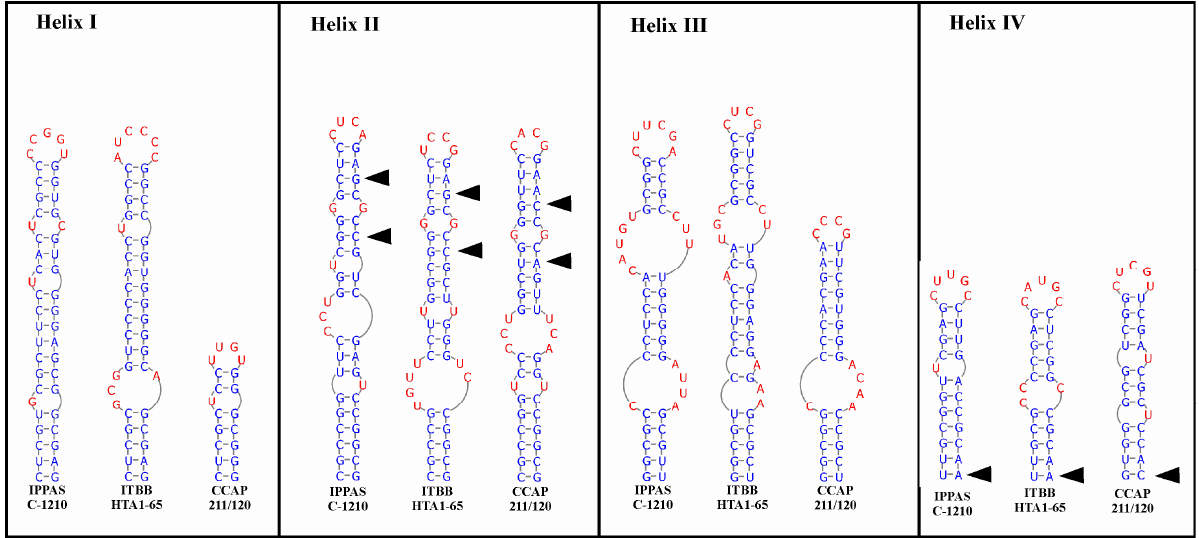
Figure 4. ITS1 secondary structure of Neochlorella semenenkoi IPPAS C-1210, N. thermophila ITBB HTA 1–65, and C. volutis CCAP 211/120. Black arrow—CBC.